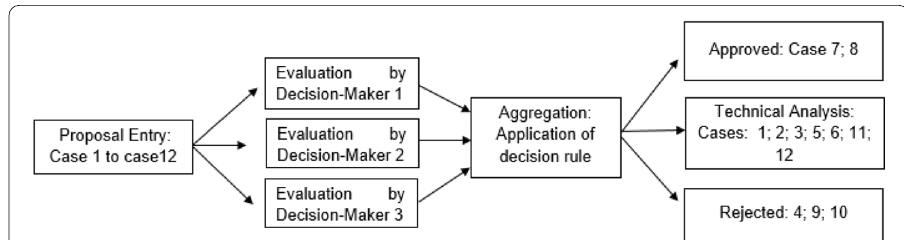
Fig. 5 The flow of the analysis process to the aggregation of the